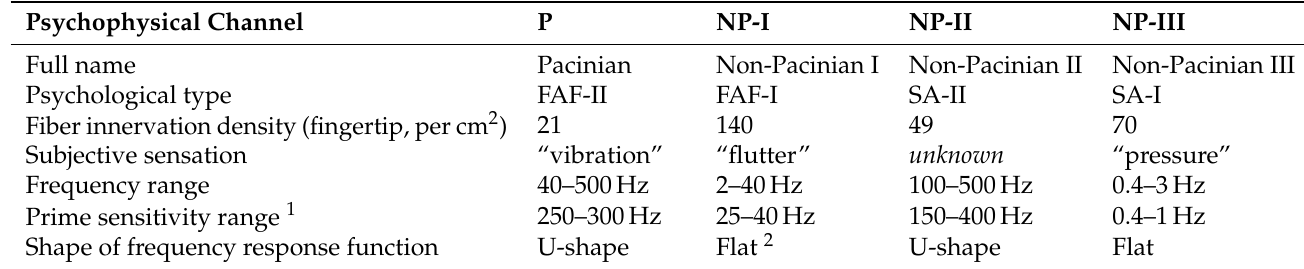
Table 1. Vibrotactile channel characteristics, adapted from